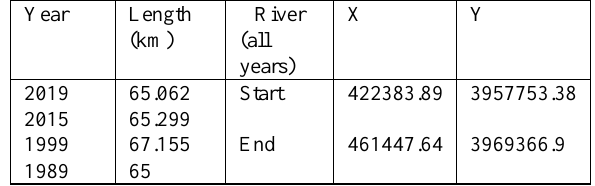
Table 3. The overall variation of river length by year.